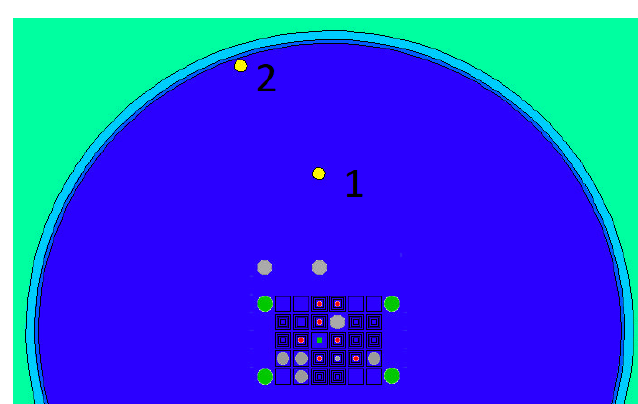
Fig. 6 Visualized position of detectors compared to the core in center of core horizontal plane. Position 1 - detector in upper position, Position 2 - detector in lower position